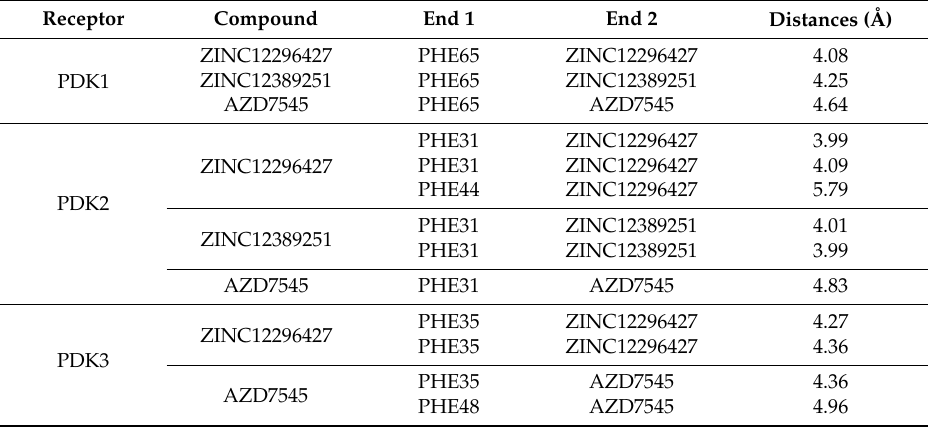
Table 6. Pi-Pi interaction parameters for each compound and PDK residues.